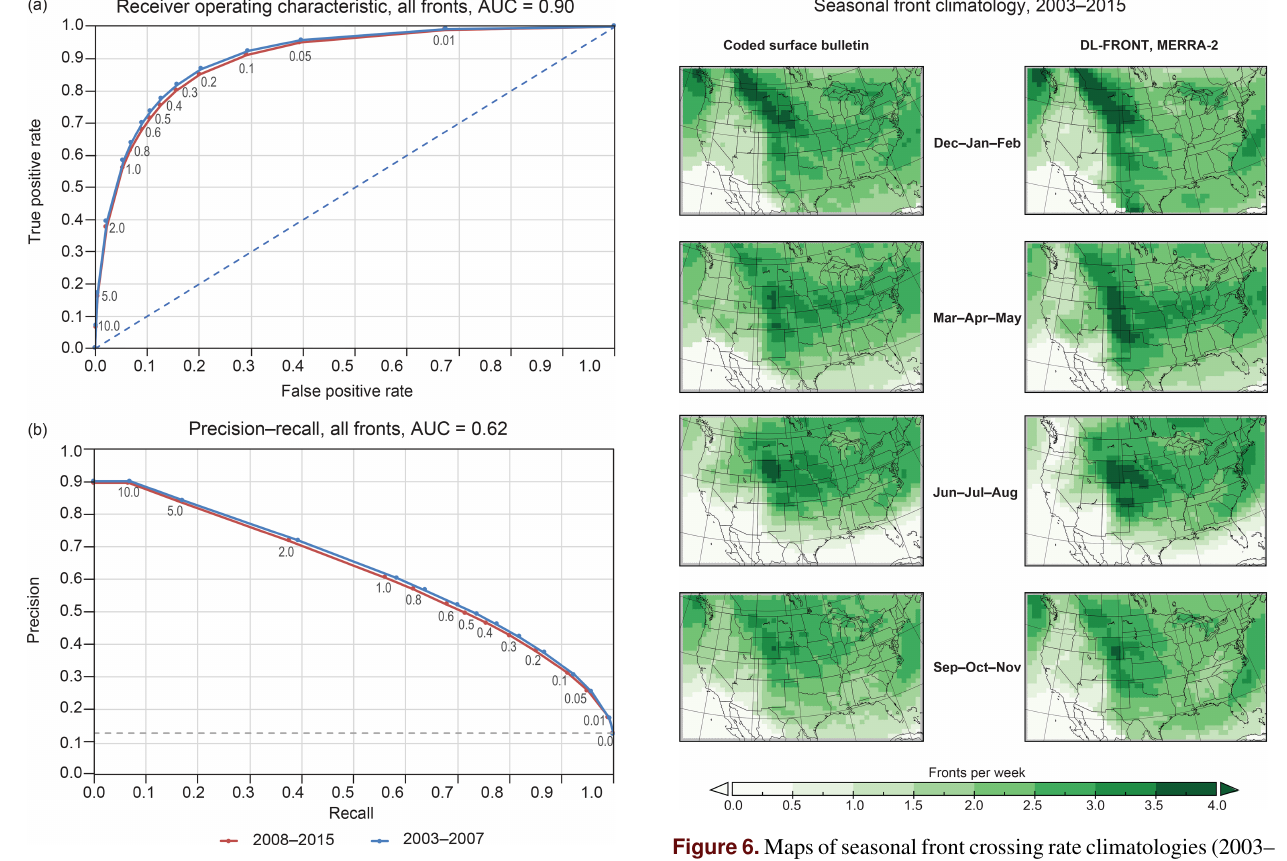
Figure 5. Receiver operating characteristic curves (a) and precision–recall curves (b) for the simplified front/no-front cate- gories over the 2008–2015 validation and 2003–2007 training time ranges.